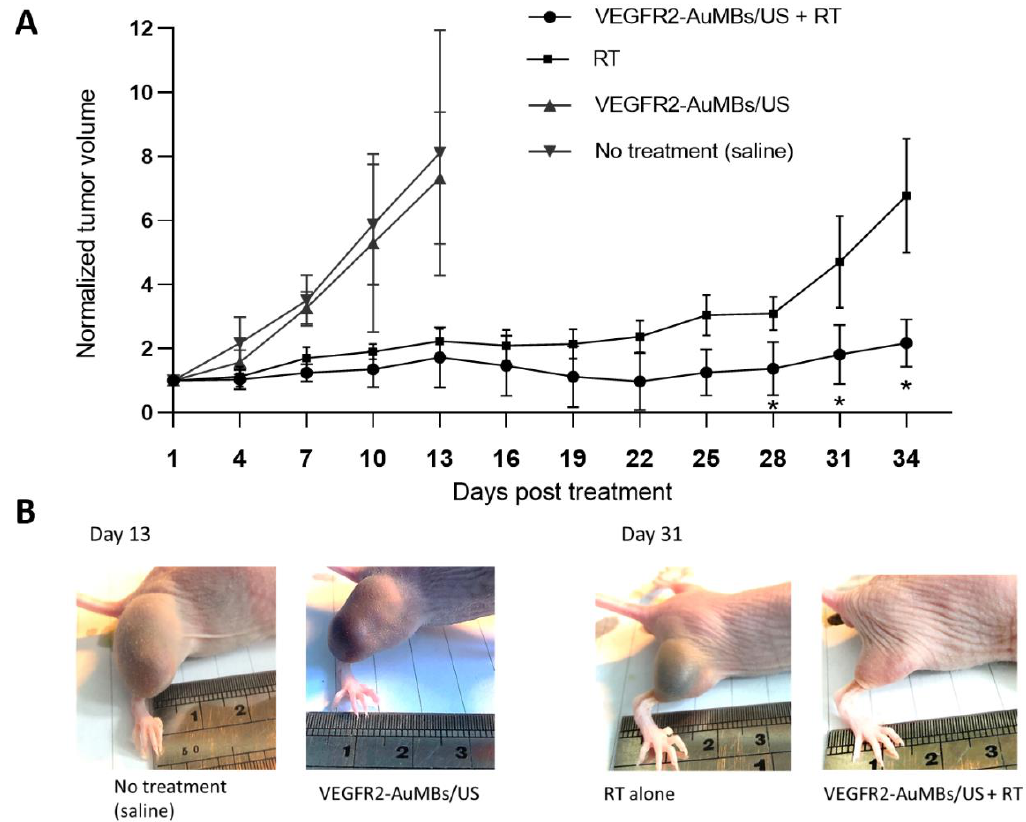
Figure 9. Tumor growth in Huh7 xenograft models with and without AuMBs/sonoporation prior to 6-MV irradiation. ( A ) Normalized tumor volume after treatment ( n = 3 in each group). ( B ) Representative mice from each group. * p < 0.05, compared with RT alone. Data are mean and SD values.